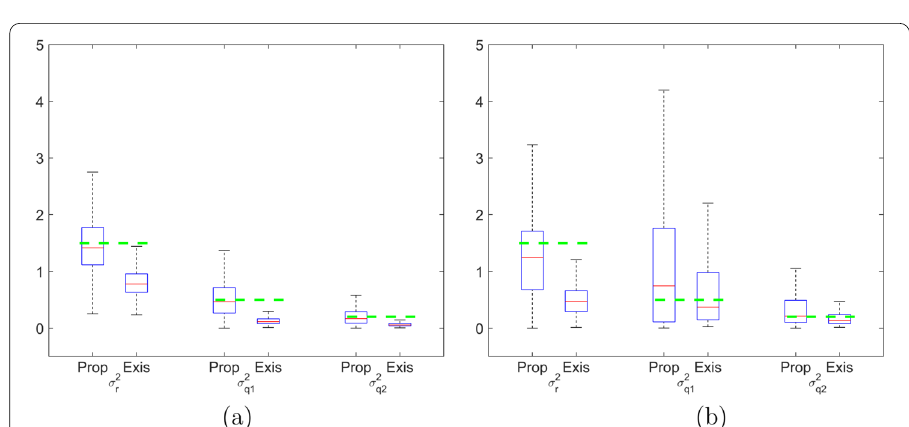
Fig. 6 Variance estimates from simulations with proposed and existing ML methods. Horizontal dashed lines show the true variances. a Linear and b nonlinear vehicle